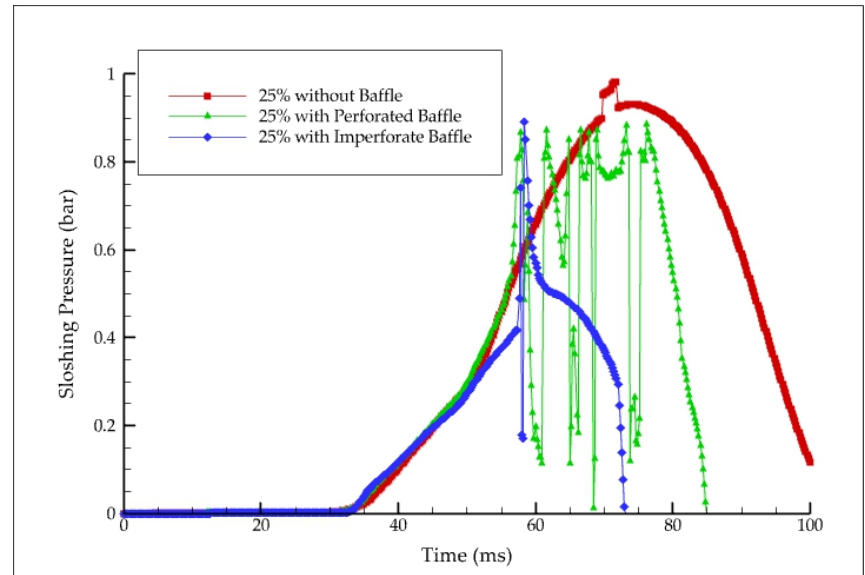
Figure 7. Comparison of sloshing pressure effect between unbaffled and baffled rectangular tanks with perforated and imperforate baffles under 25% filling ratio.